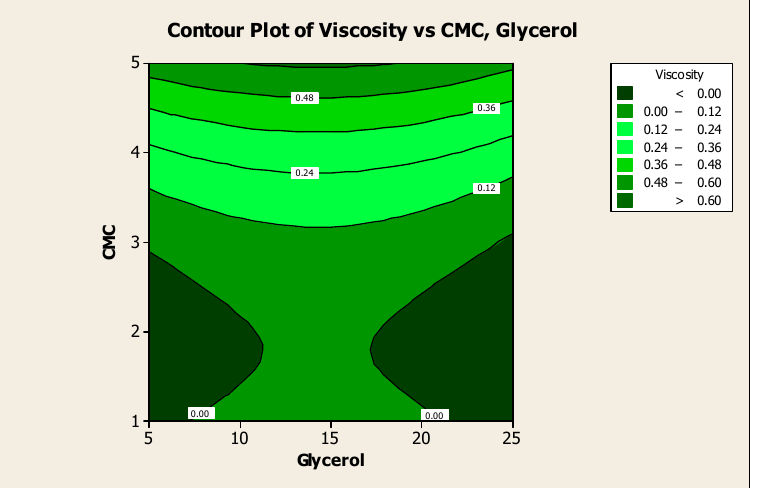
Figure 3. Contour plot for the effect of glycerol and CMC concentration on the viscosity of mangosteen-leaves-based marker ink.